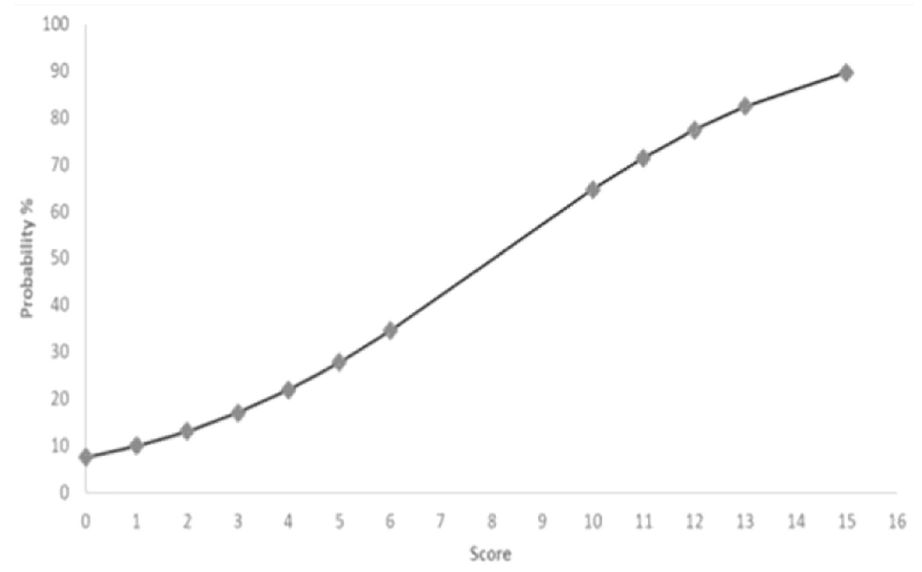
Fig 1. Association between Pseudomonas mortality score and probability of death. Pseudomonas mortality score = sum of individual risk factors (1 point for recent steroid use, 2 points for identified respiratory culture, 3 points for malignancy, 10 points for